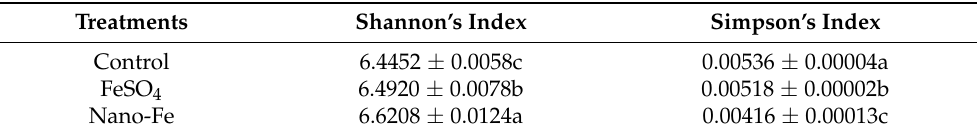
Table 4. Effect of exogenous Fe applications on Shannon ’ s and Simpson ’ s indices of the bacterial communities.